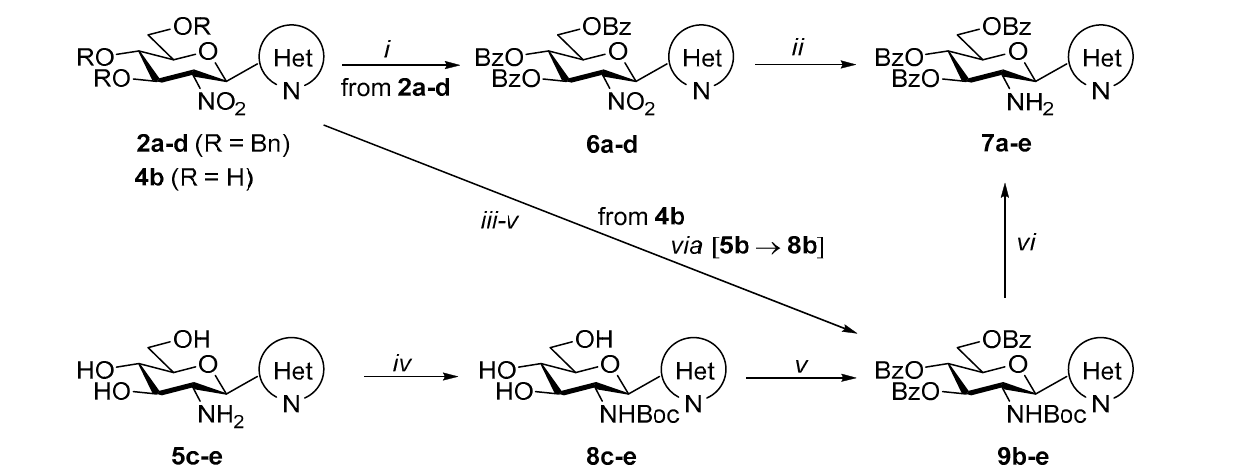
Table 3. Synthesis of C -(2 (cid:48) -amino-2 (cid:48) -deoxy-3 (cid:48) ,4 (cid:48) ,6 (cid:48) -tri- O -benzoyl- β - D -glucopyranosyl)azines.